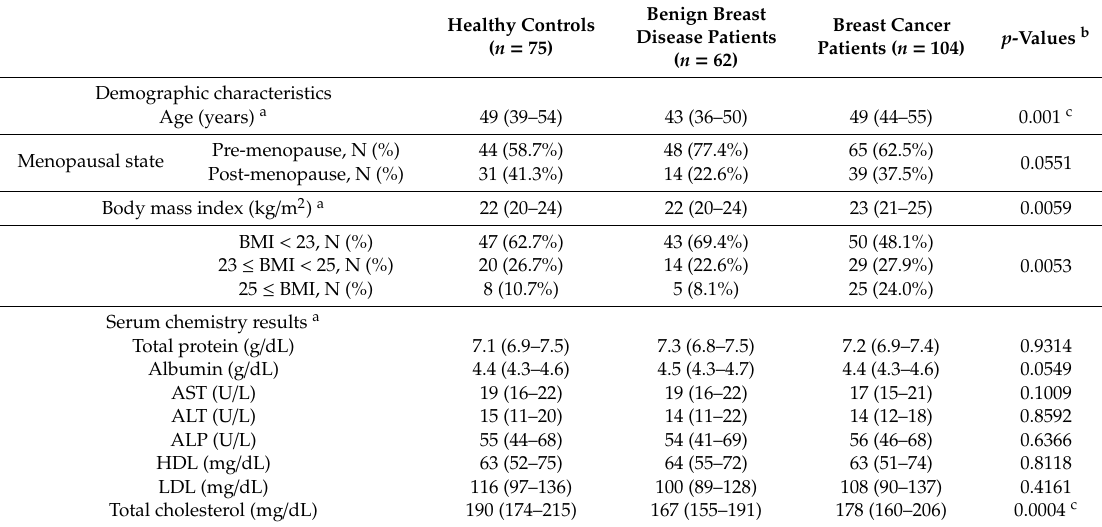
Table 1. General characteristics of the study population.